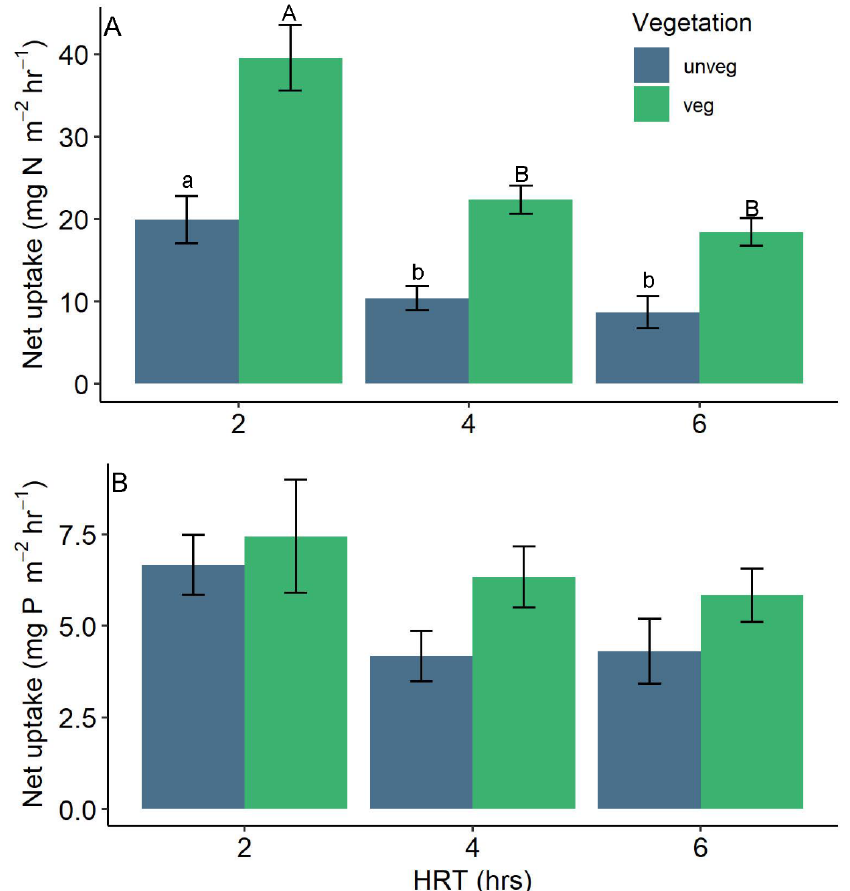
Figure 3. Drainage ( A ) nitrate and ( B ) soluble reactive phosphate (SRP) hourly net uptake rates by hydraulic residence time and vegetation treatment for all runs. Letters distinguish significant differences among HRT treatments within vegetation treatments. Bars are the means and error bars represent the standard error of the mean.